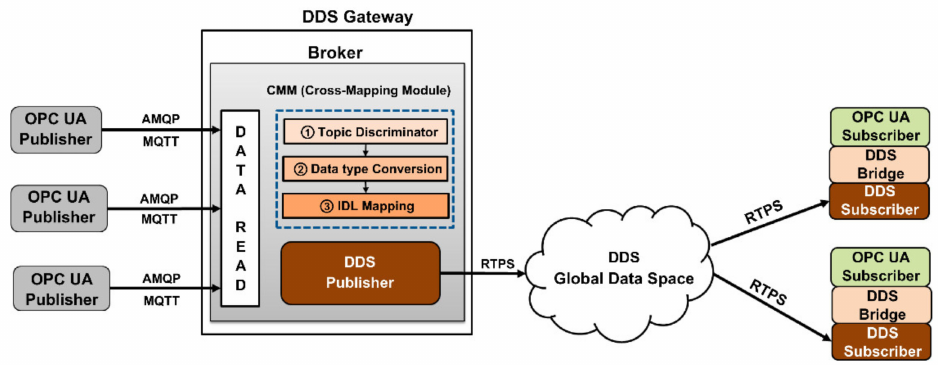
Figure 5. Overall system architecture of the OPC UA protocol